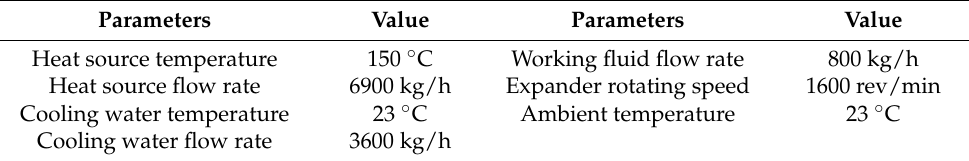
Table 4. The main parameters of the ORC system at the design point.